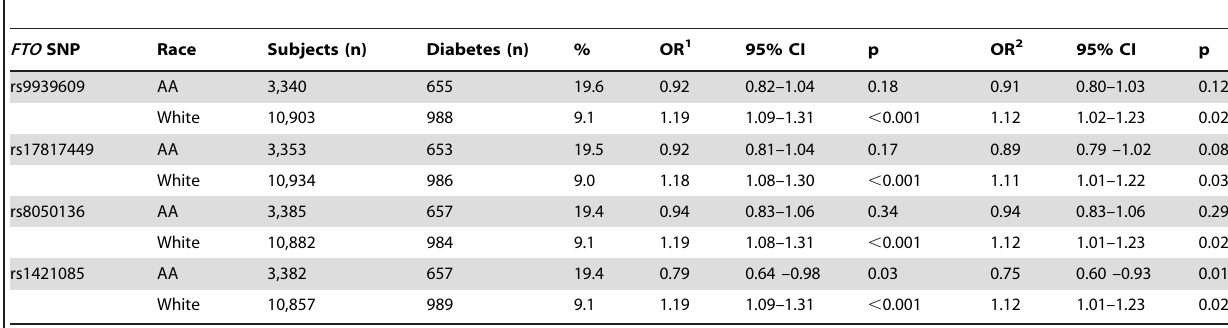
Table 5. Association of FTO risk alleles and diabetes stratified by race.